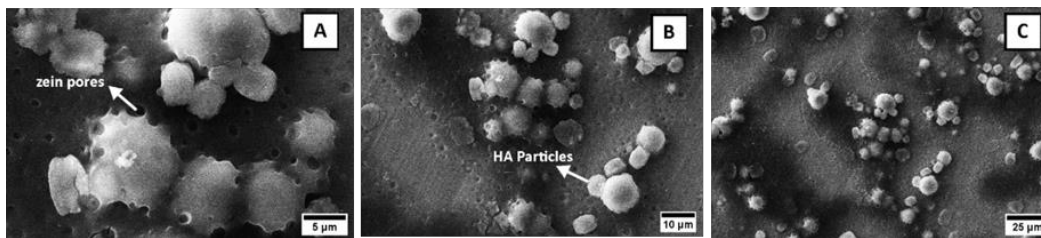
Figure 2. SEM images of a zein/HA coating on stainless steel, obtained via vertical standing EPD at different magnifications (parameters: 5 g/L of HA in the suspension, 3 min, 15 V); ( A )at 5µm resolution, ( B ) at 10 µm resolution, ( C ) at 25 µm resolution.